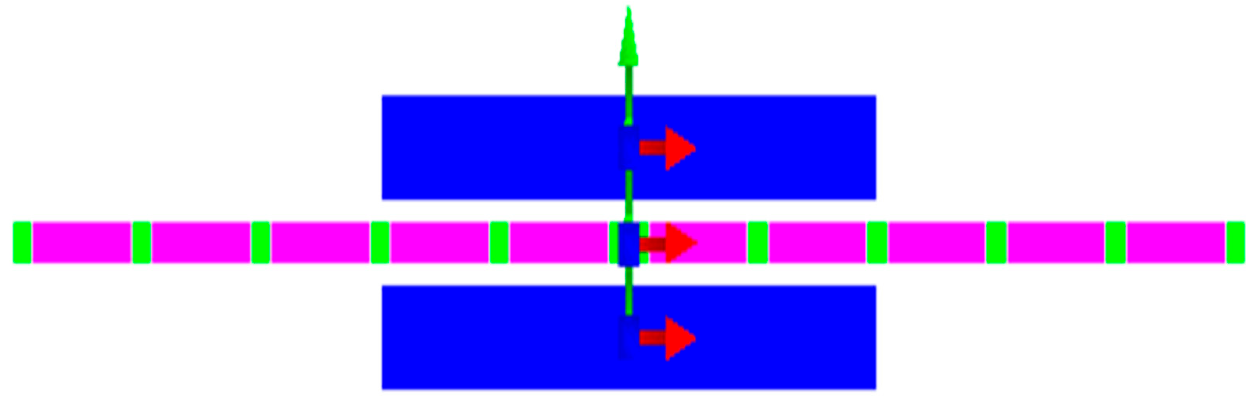
Figure 13. Physical model of the gadolinium motor.